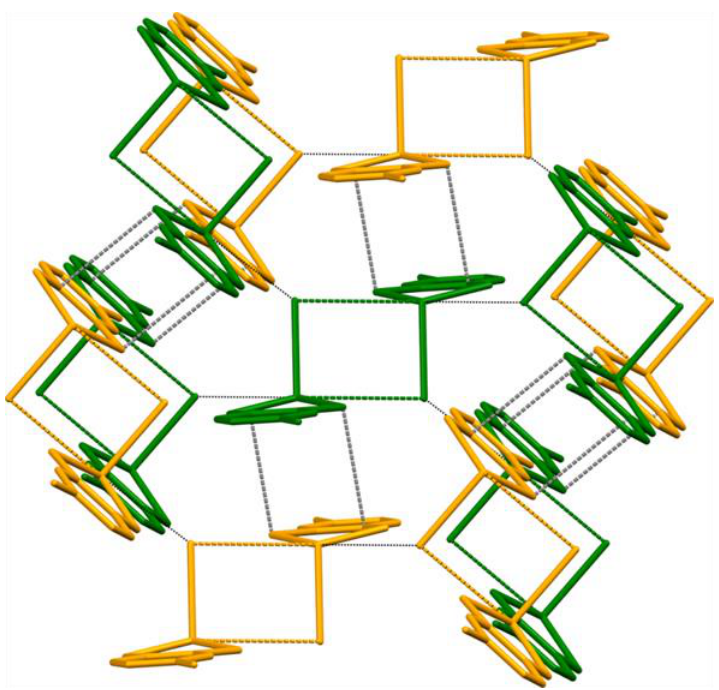
Figure 5. Fragment of the crystal structure of 3 and 4 showing some intermolecular interactions.